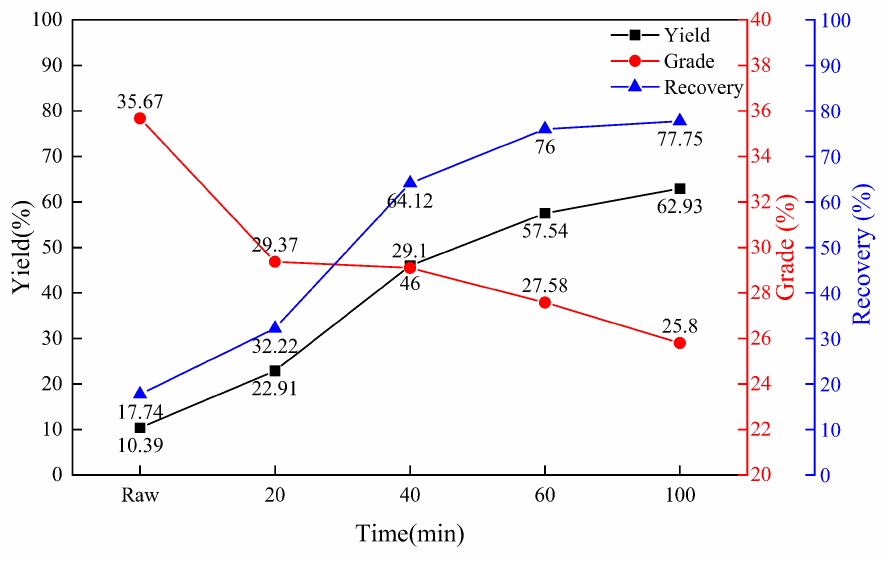
Figure 7. Magnetic separation effect under different oxidation time at 75